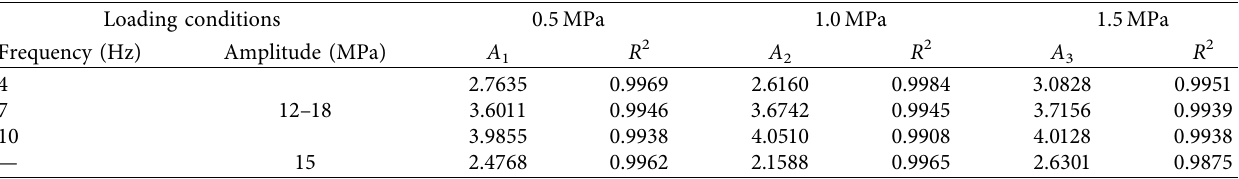
Figure 4: Fit curves for the diffusion coefficient of the samples in the early stage under different loading frequencies. (a) Equilibrium pressure of 0.5 MPa. (b) Equilibrium pressure of 1.0MPa. (c) Equilibrium pressure of 1.5MPa. Table 4: Fit results for the relationship between the desorption capacity of the briquette samples within 2.64min and the square root of time under different loading